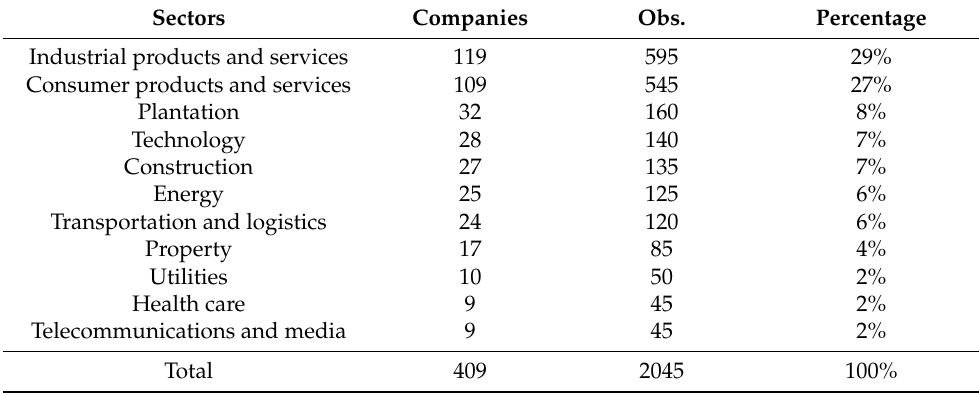
Table 1. Sample Table 1. Sample classification.